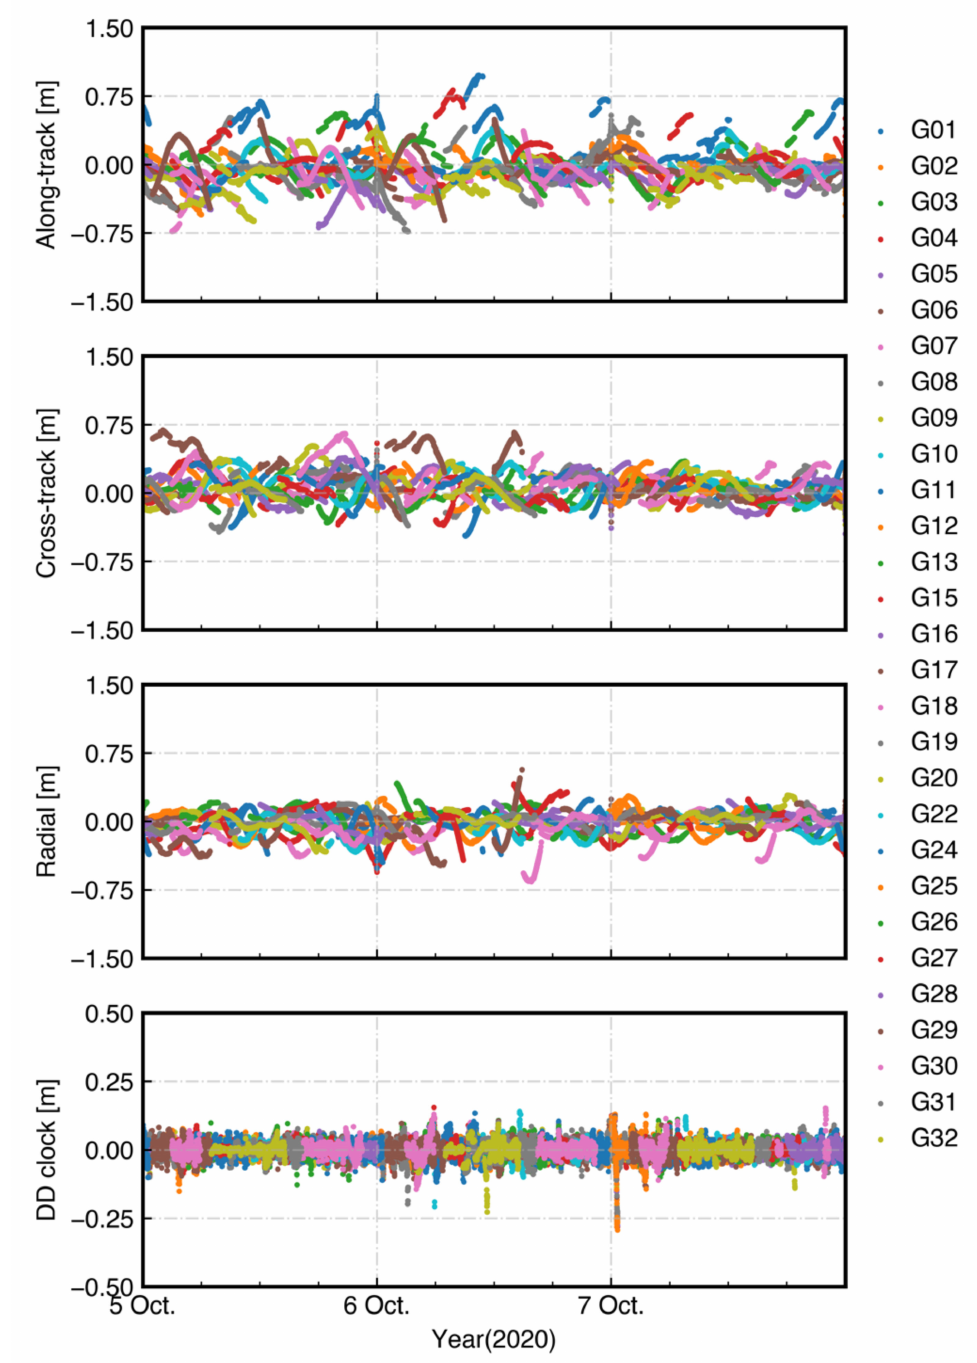
Figure 3. GPS PPP-B2b orbit and clock errors from 5 October 2020 to 7 October